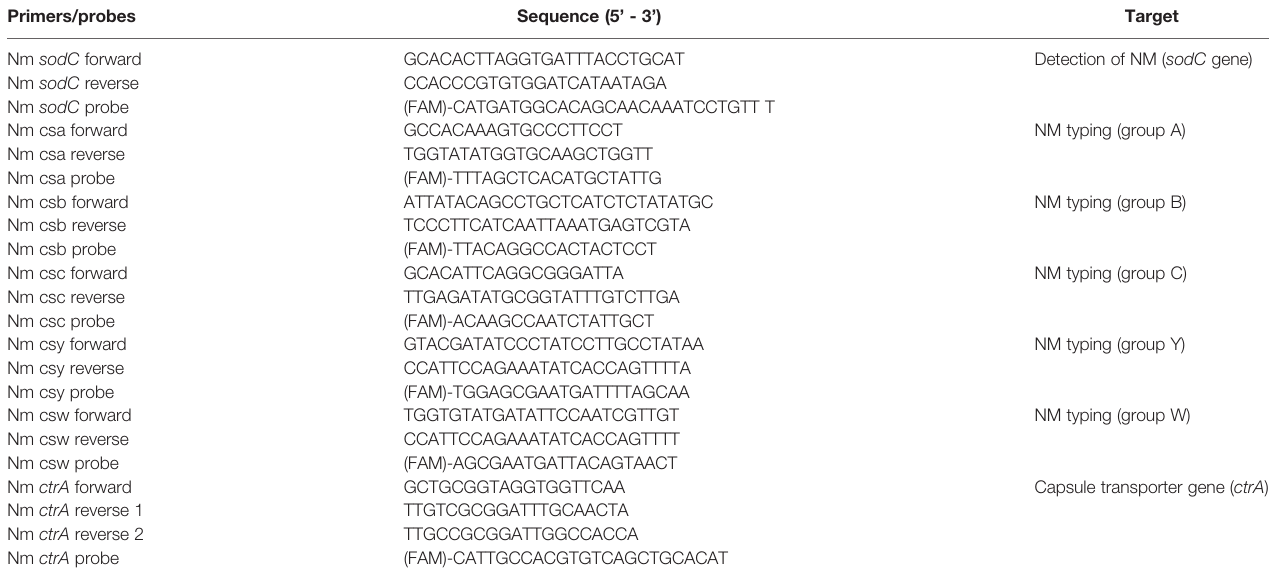
TABLE 1 | Real-time PCR primers and probes used for N. meningitidis detection, typing, and assessment of capsular status.